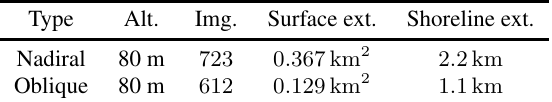
Table 2. Flight plan specifications.